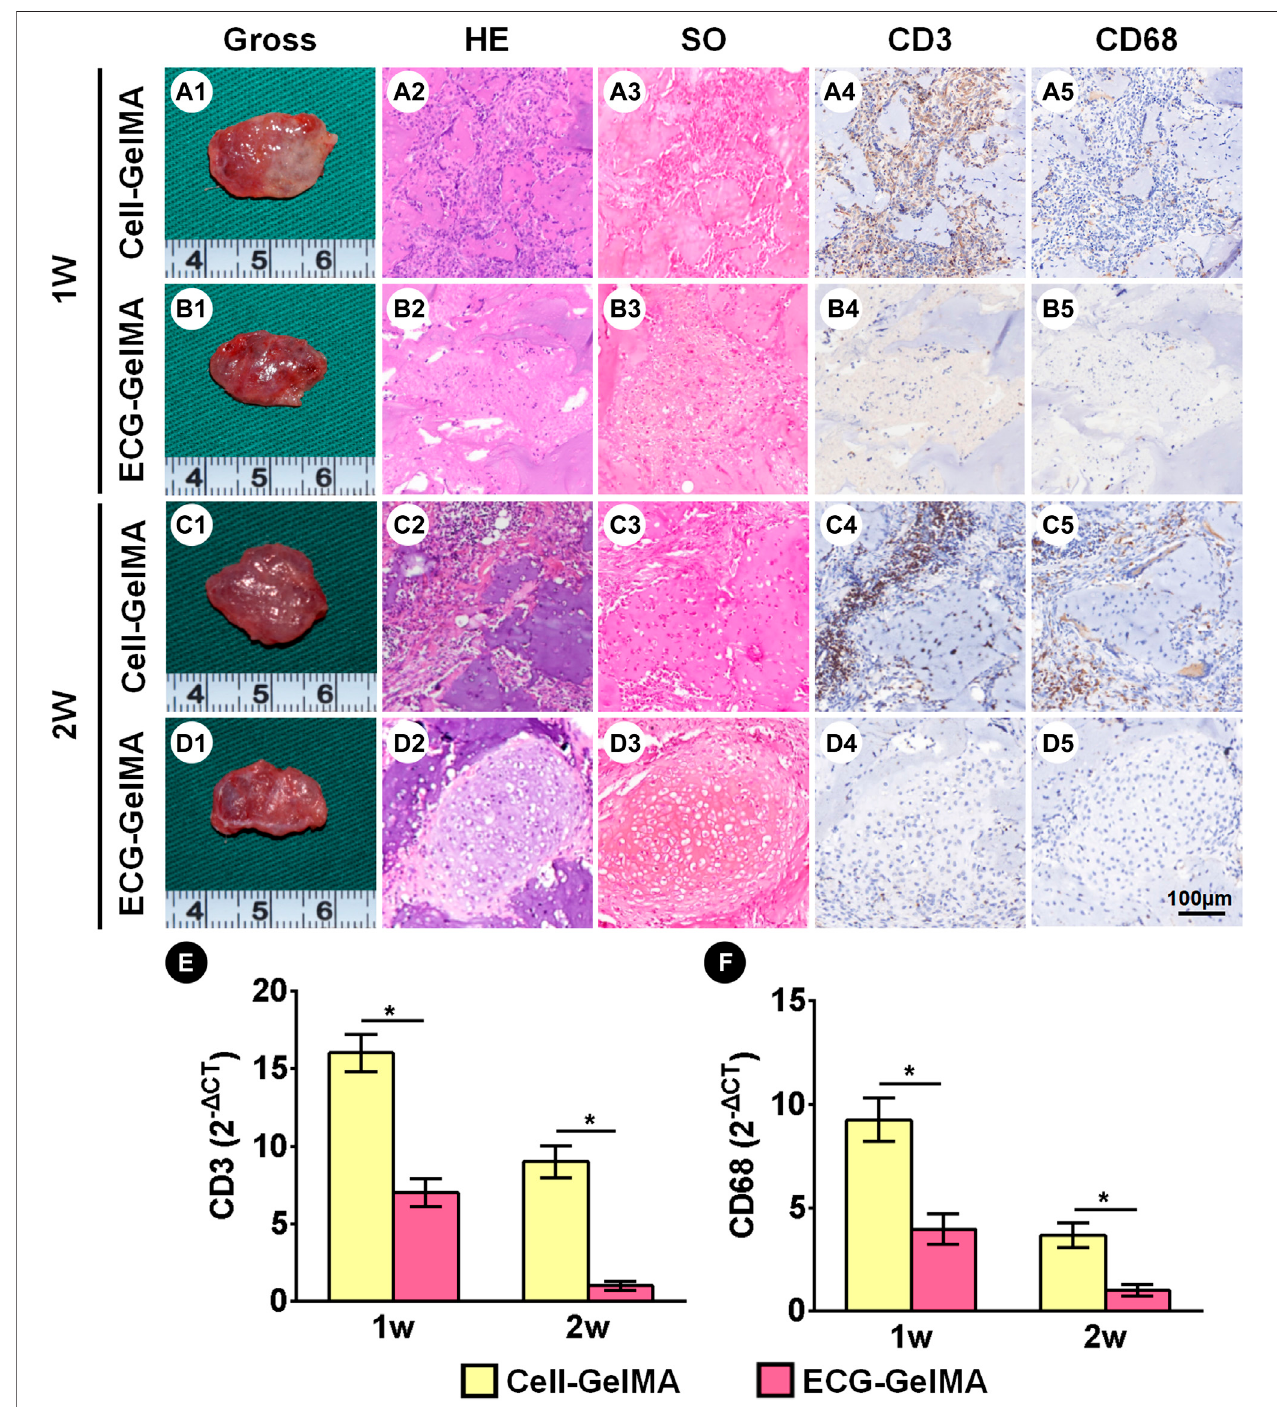
FIGURE 6 | In fl ammatory response evaluations of Cell-GelMA and ECG-GelMA constructs subcutaneously implanted into goats for 1 and 2 weeks. Gross view of samples in Cell-GelMA, ECG, and ECG-GelMA groups subcutaneously implanted into goats for 1 week (A1-B1) and 2 weeks (C1-D1). HE (A2-D2), SO (A3-D3), immunohistochemicalCD3(A4-D4)and CD68(A5-D5)stainingofsamplesinCell-GelMA, ECG,andECG-GelMAgroupssubcutaneouslyimplanted intogoatsfor1and 2weeks.ExpressionofCD3(E)andCD68(F)genesCell-GelMA,ECG,andECG-GelMAgroupssubcutaneouslyimplanted intogoats for1and 2weeks* p < 0.05.